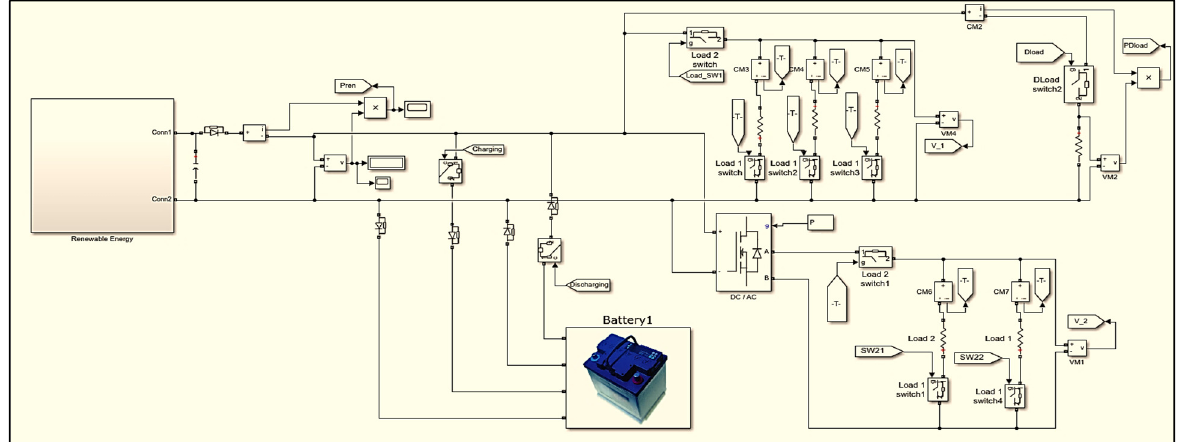
Fig. 3: Overall system design in Matlab/Simulink Table 2: Wind input parameter Wind Turbine Parameters